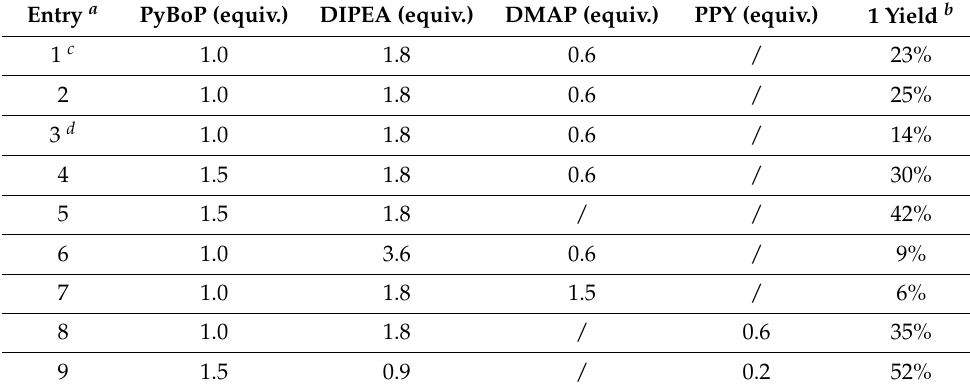
Table 1. Optimization of reaction.